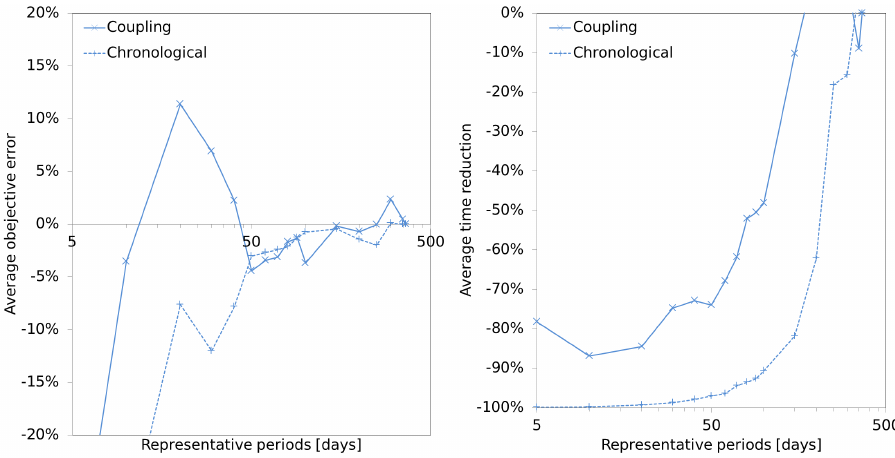
Figure 9. Average objective error ( left ) and average time reduction ( right ) for the 10 nodes test case for the coupling and chronological clustering using different representative